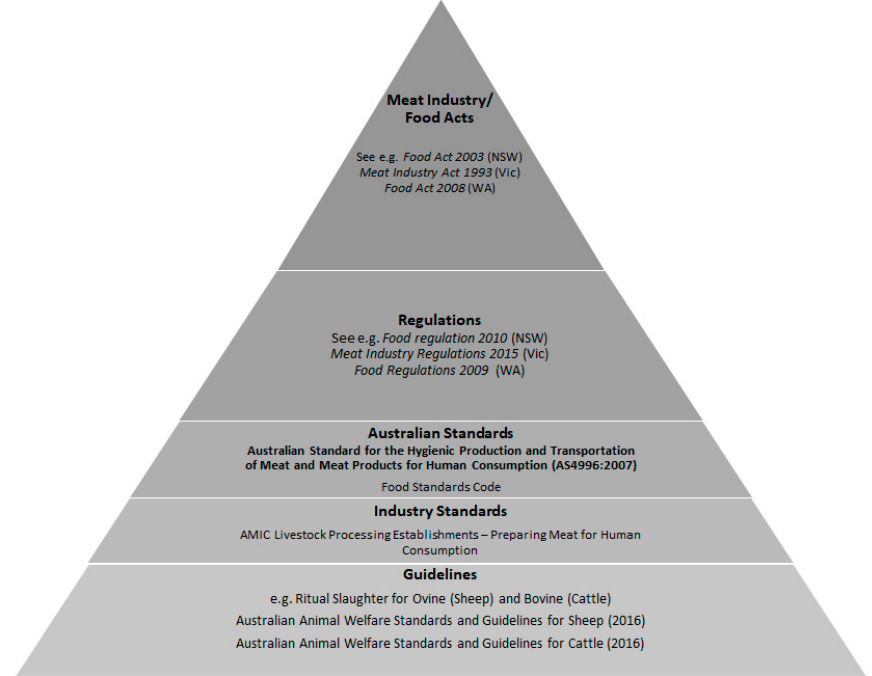
Figure 1. Hierarchy of state and territory legal regime in relation to religious slaughter. Note that standards and guidelines listed are illustrative and do not represent a comprehensive list.